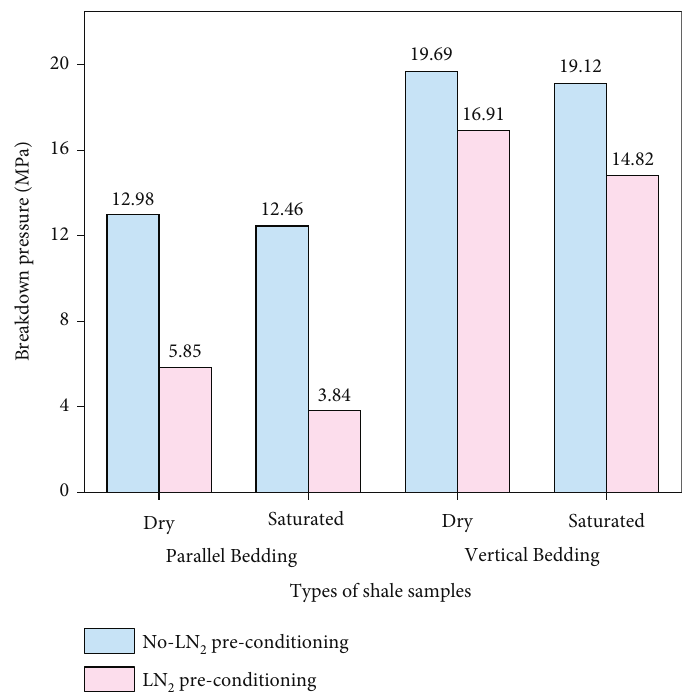
Figure 11: Average breakdown pressure comparison between parallel and vertical bedding